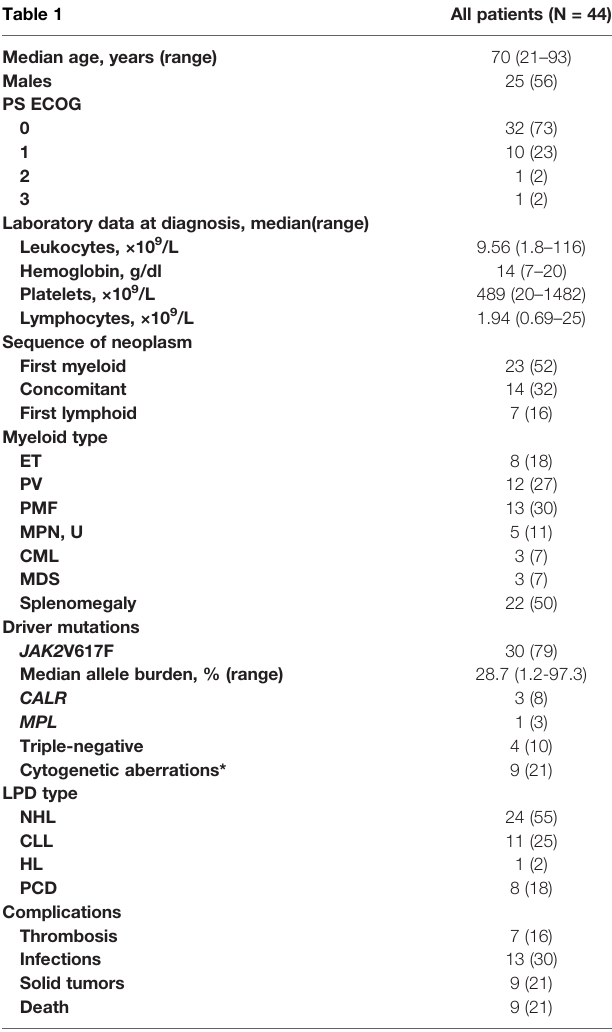
TABLE 1 | Clinical and hematological characteristics of patients with concomitant myeloid and lymphoid neoplasms. Table 1 All patients (N = 44) Median age, years